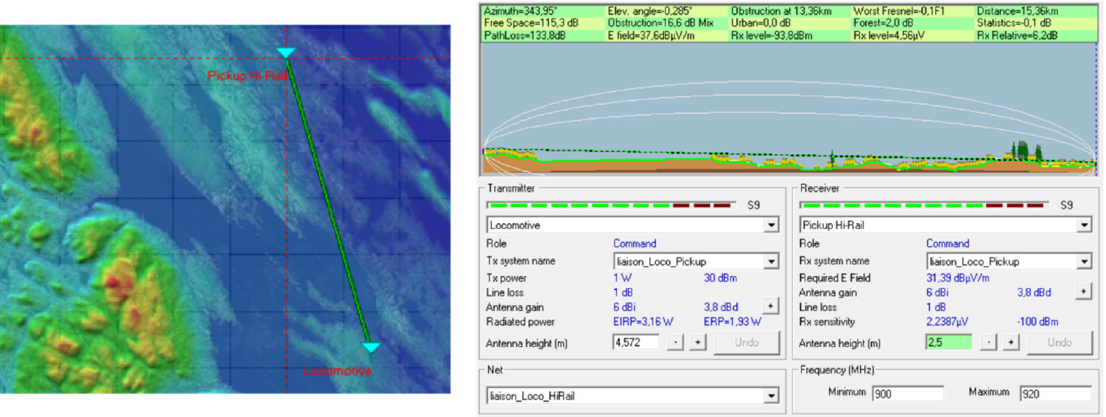
Figure 14. Budget link at Menihec on the railway.